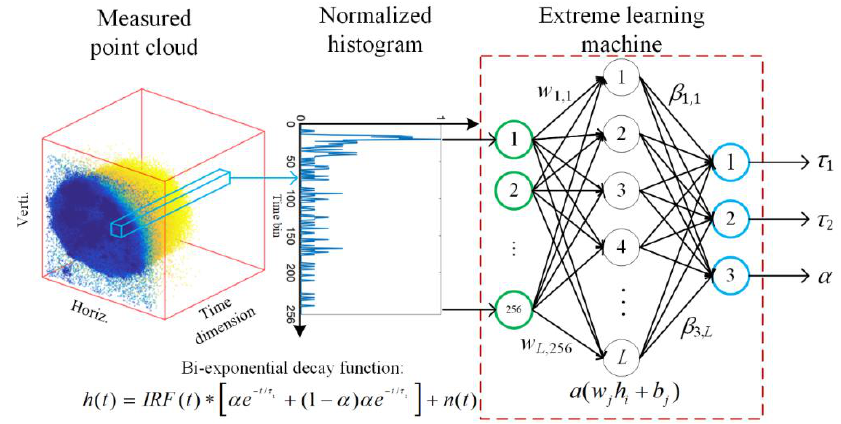
Figure 1. ELM is used for lifetime analysis. The input data are a 1-D pixel-wise histogram from the raw point cloud that contains 256 time bins. The histogram is fed into a single-hidden-layer ELM, and lifetime parameters ( τ 1 , τ 2 , and α ) can be obtained from output nodes.